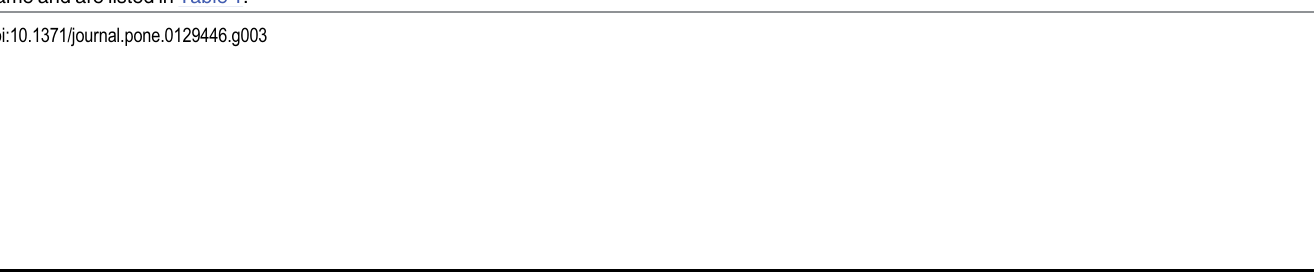
PLOS ONE | DOI:10.1371/journal.pone.0129446 June 12,